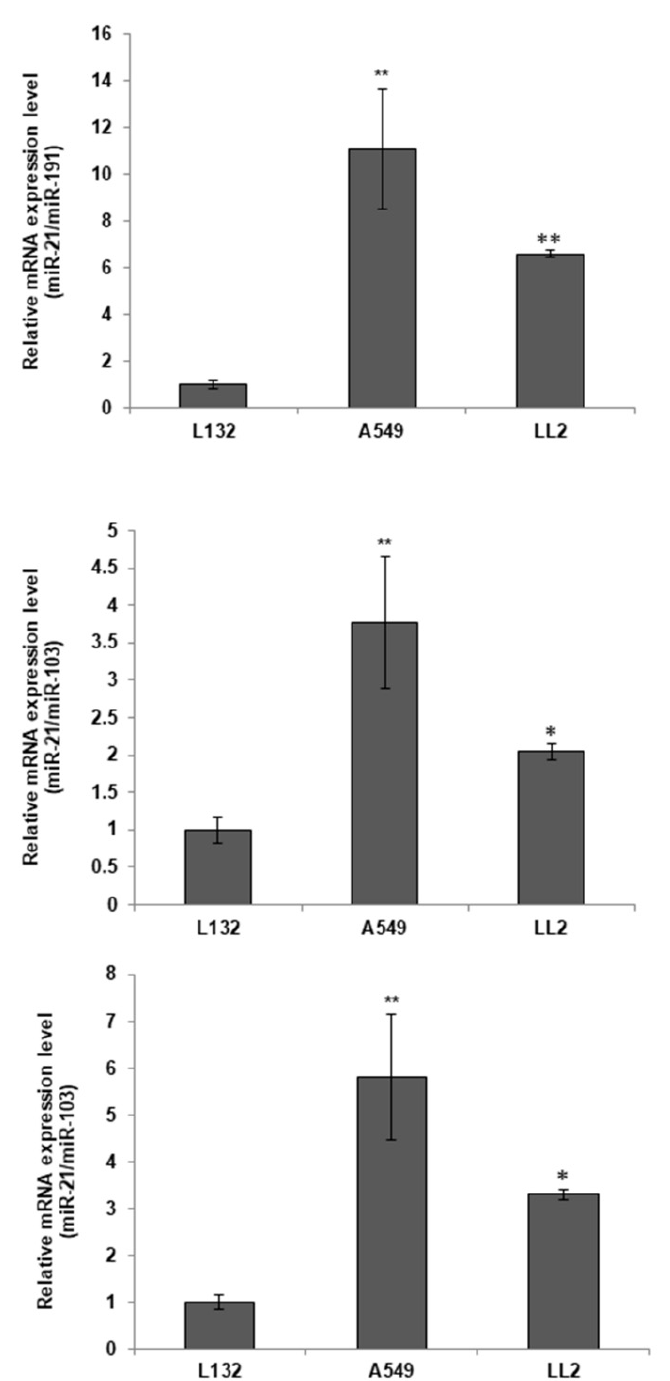
than in both LL2 and L132 lung cancer cell lines. L132 cells showed the lowest levels of miR-21 expression.